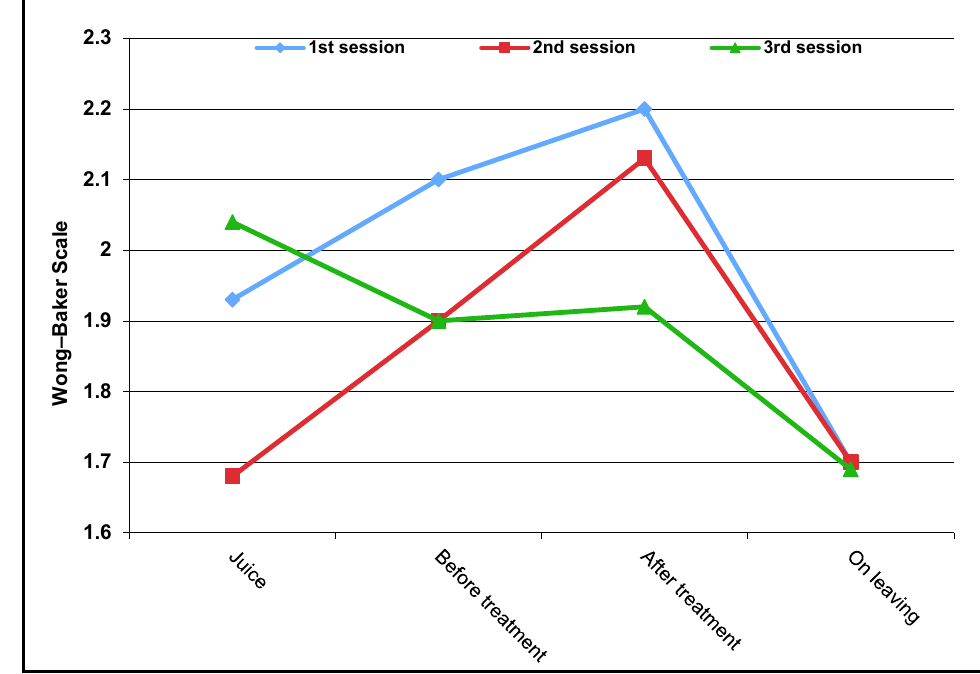
Figure 3. Self-assessment of the children during treatment.